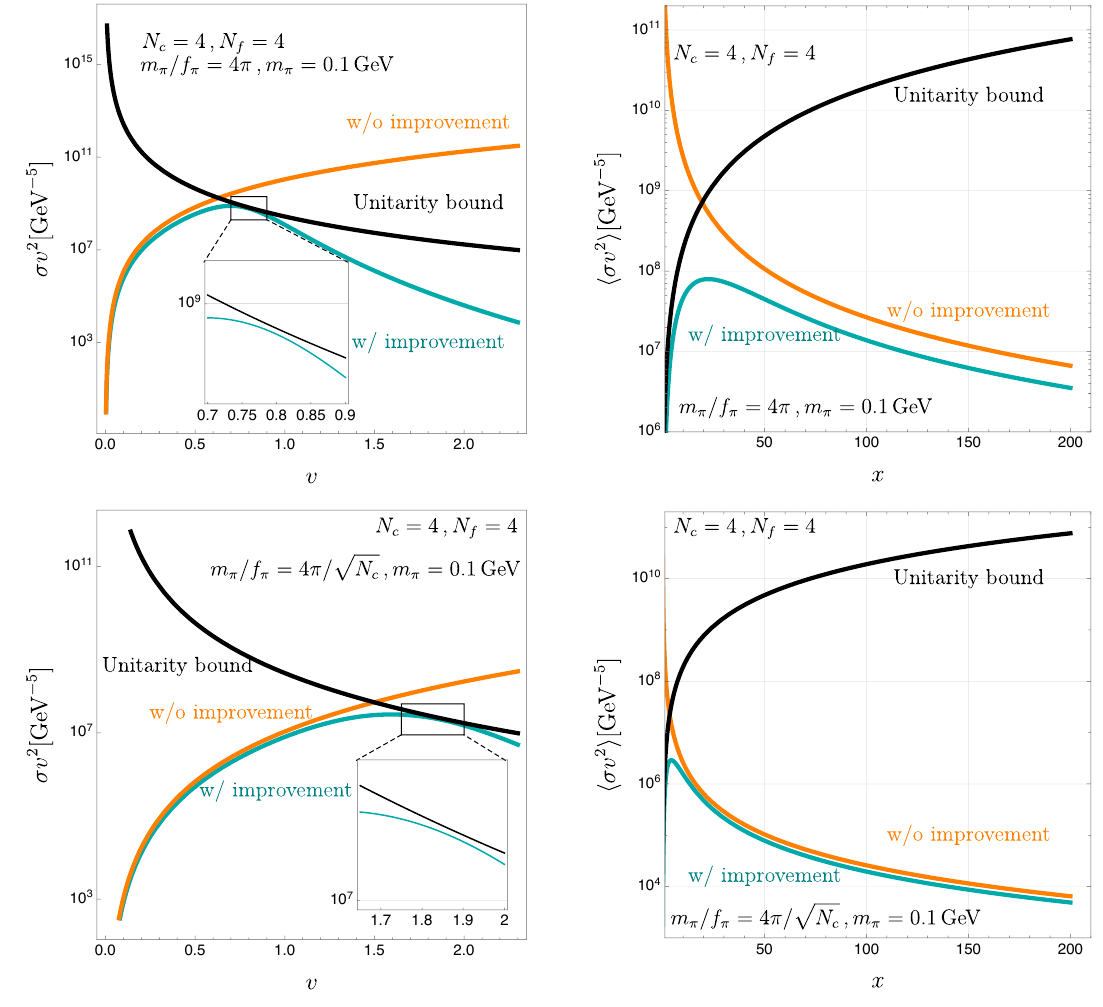
Figure 4 . Comparison of the πππ → ππ (thermally-averaged) cross sections. The symmetry structure is assumed to be SU(4) × SU(4) / SU(4) , and we take m π = 0 . 1 GeV . We take m π /f π = 4 π √ in top panels and m π /f π = 4 π/ N c in bottom panels. ( Left ): shown is the cross sections σv 2 with improvement (cyan), the cross section without improvement (orange), and unitarity bound (black) as a function of velocity v . ( Right ): shown is the thermally-averaged cross section h σv 2 i with improvement (cyan), without improvement (orange), and unitarity bound (black) as a function of x = m π /T